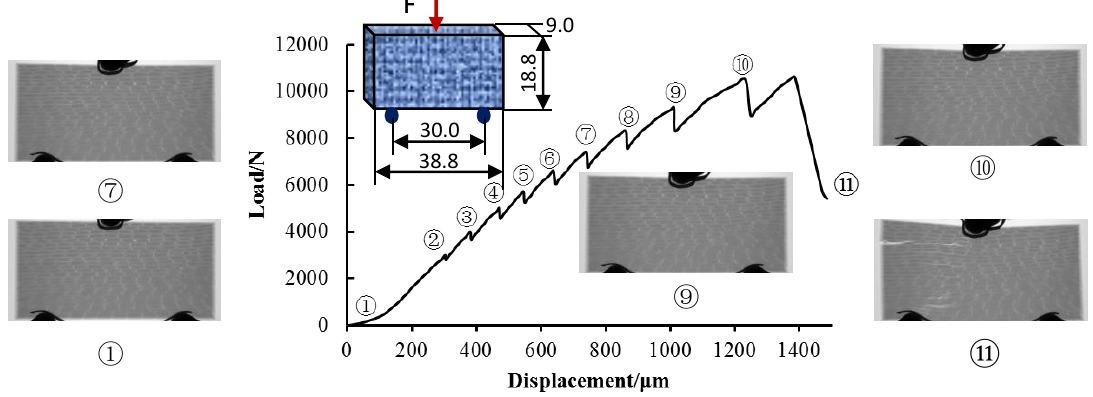
Figure 8. Loading–displacement curve and radiography projections of step 1, step 7, step 9, step 10 and step 11.